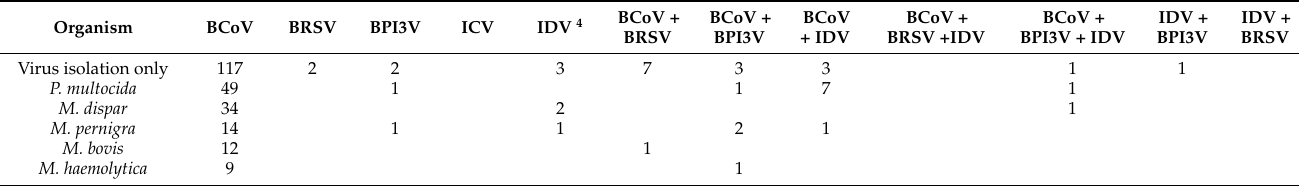
including both viral and bacterial analyses was available for 657 out of a total of 764 samples included in this study. Out of these 657 samples, 384 tested positive for at least one of the viral pathogens analyzed in this study, 273 tested negative for all viruses. BCoV: bovine